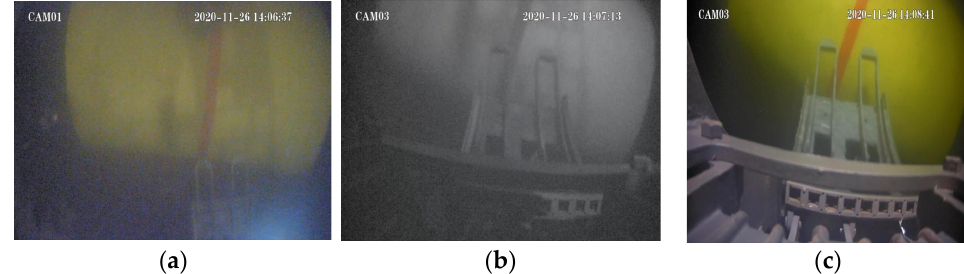
Figure 18. Images captured by cameras when the manipulator approached the object: ( a ) Object founded, ( b ) Approaching the object and ( c ) Judgement of attitude adjustment error by image.